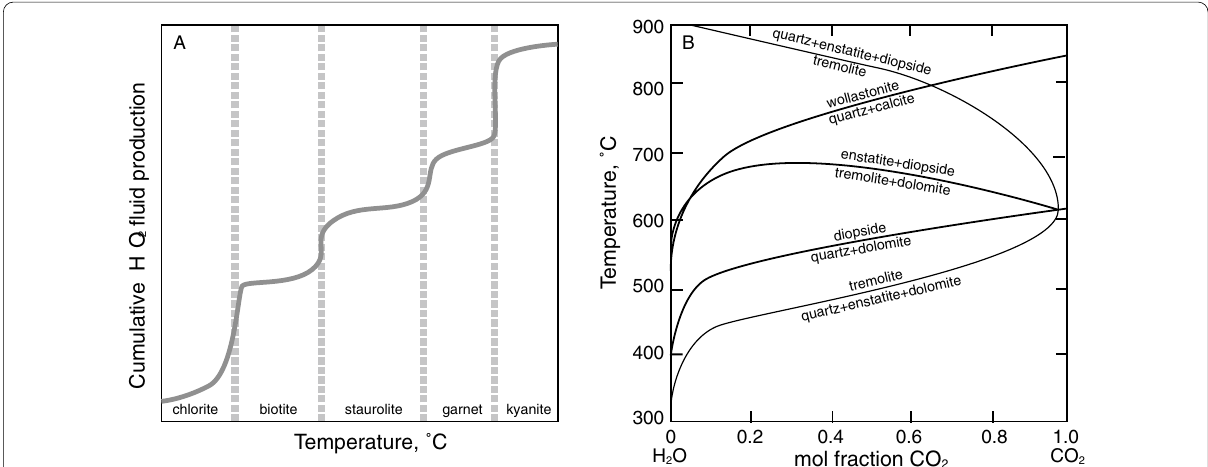
Fig. 1 H 2 and CO 2 generation during metamorphic processes. A . Cumulative H 2 O loss as a function of increasing metamorphic grade. B . CO 2 loss from decarbonation reactions at 0.5 GPa as a function of CO 2 –H 2 O fluid composition. Modified from Evans and Tomkins